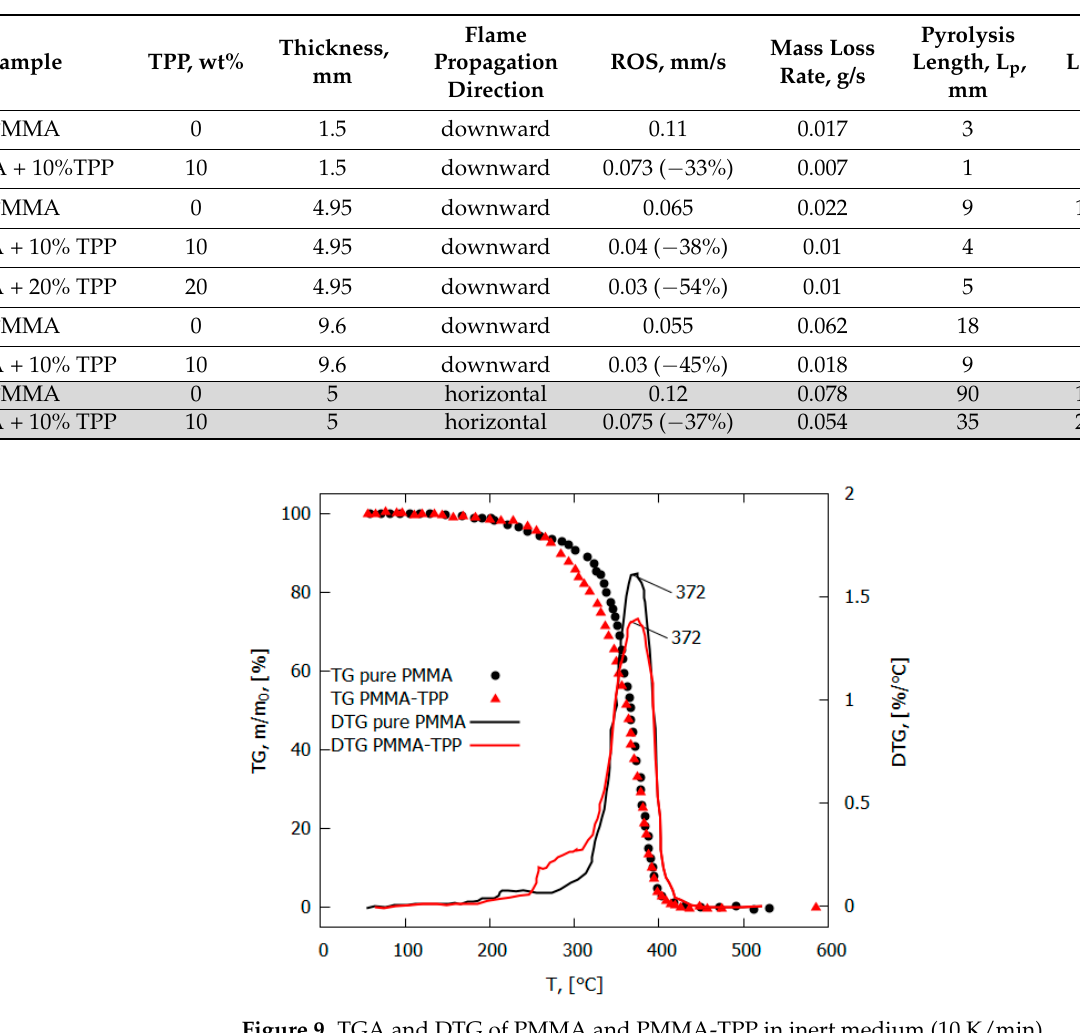
Table 1. The main flame propagation characteristics.